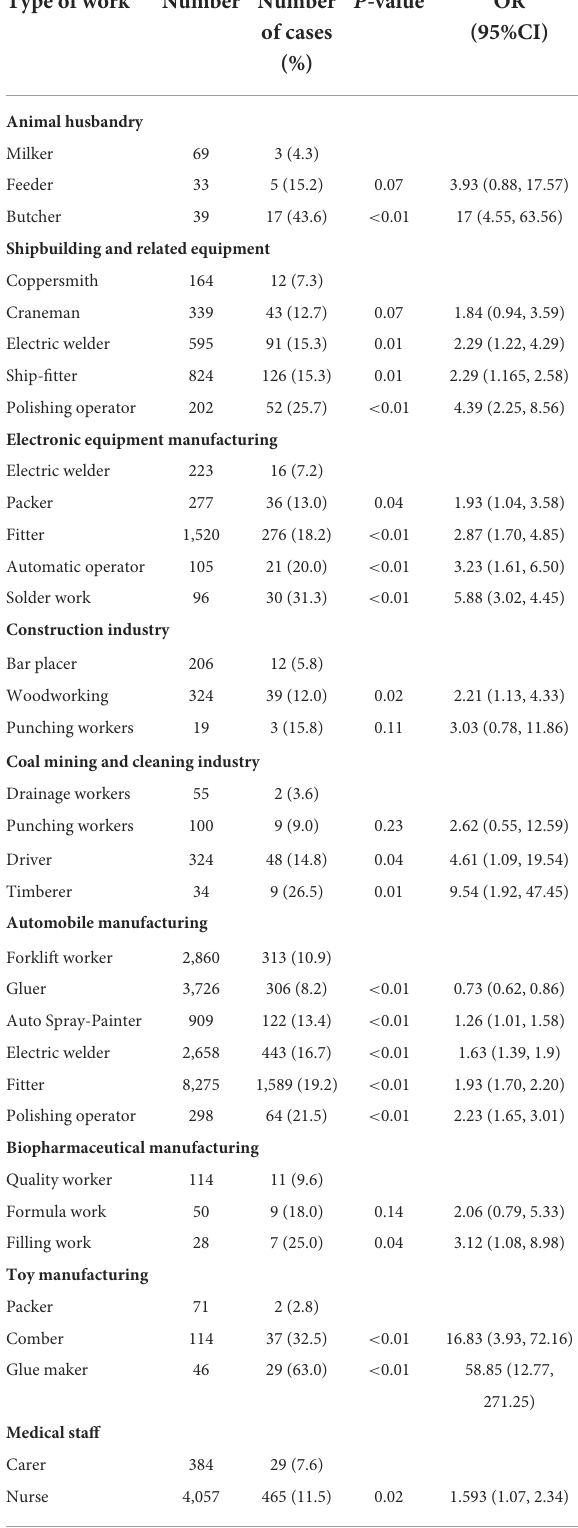
TABLE 4 Results of binary logistic regression analysis of different types of work in various industries. Type of